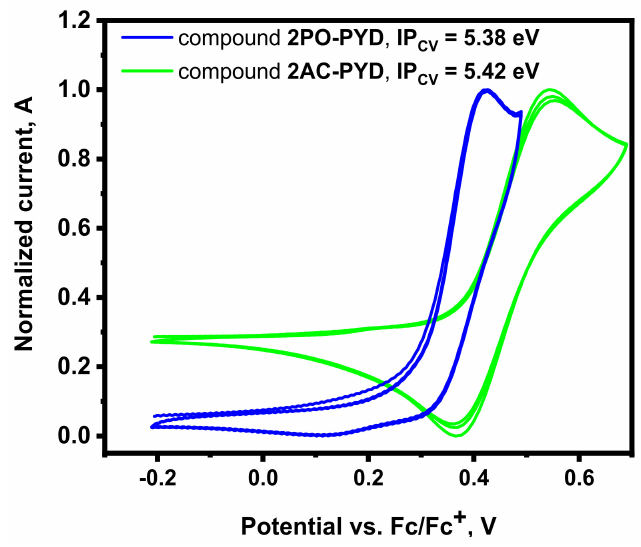
Figure 4. Cyclic voltammograms of compounds 2PO-PYD and 2AC-PYD .